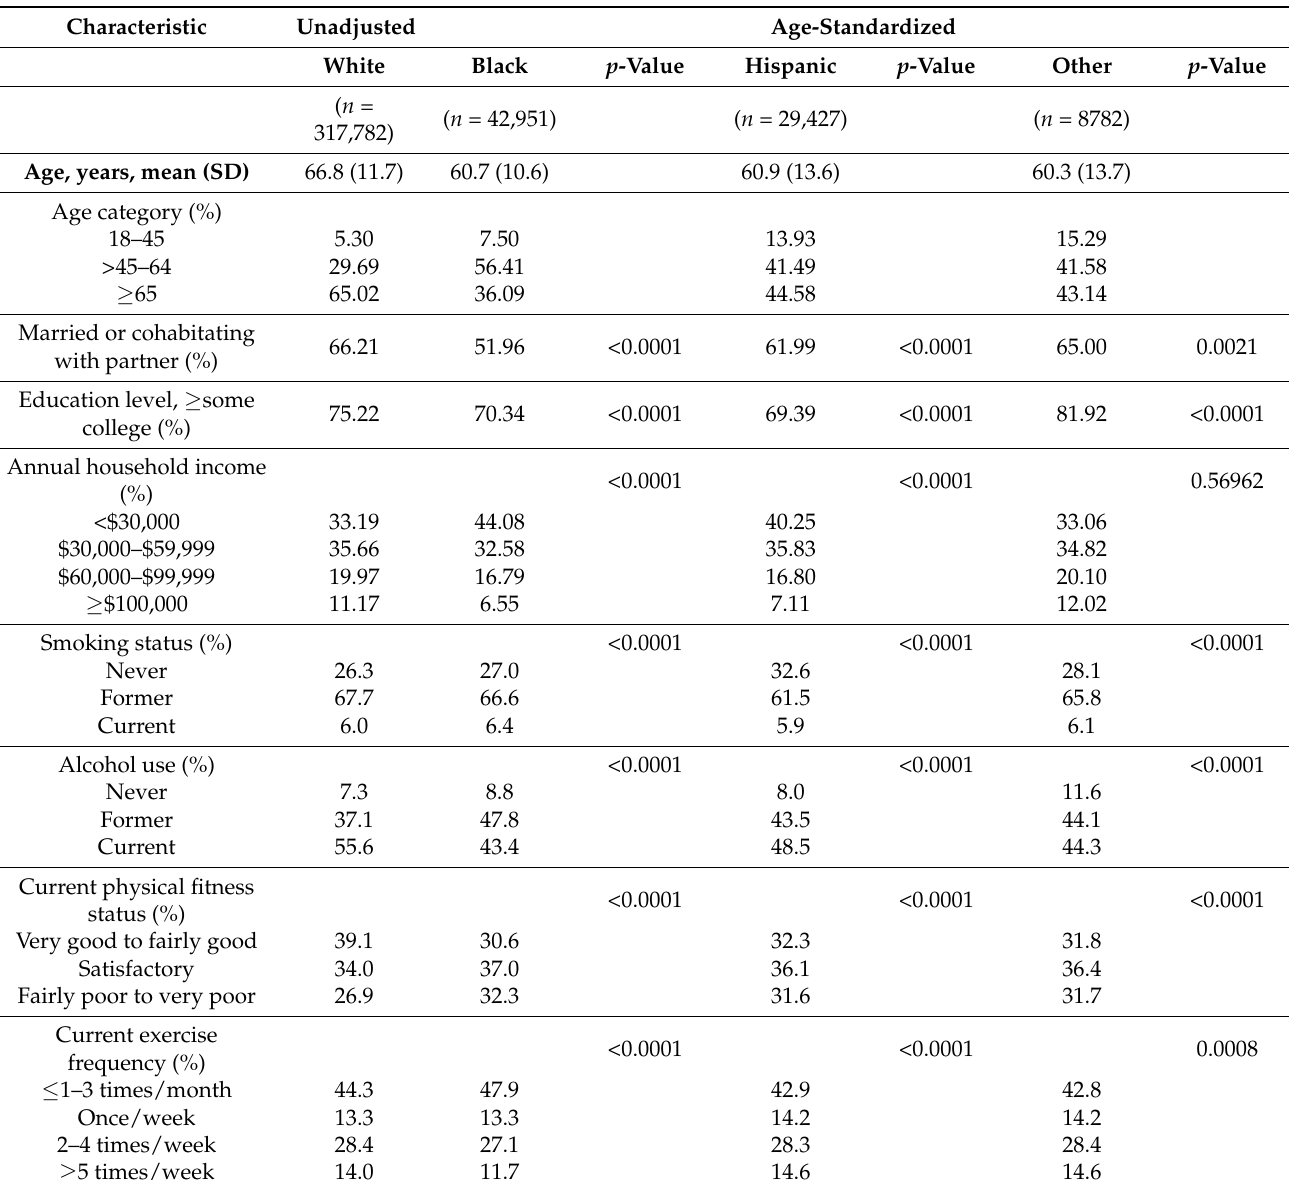
Table 1. Demographics, Lifestyle Characteristics, and Military Exposures of Men from the Million Veteran Program by Race and